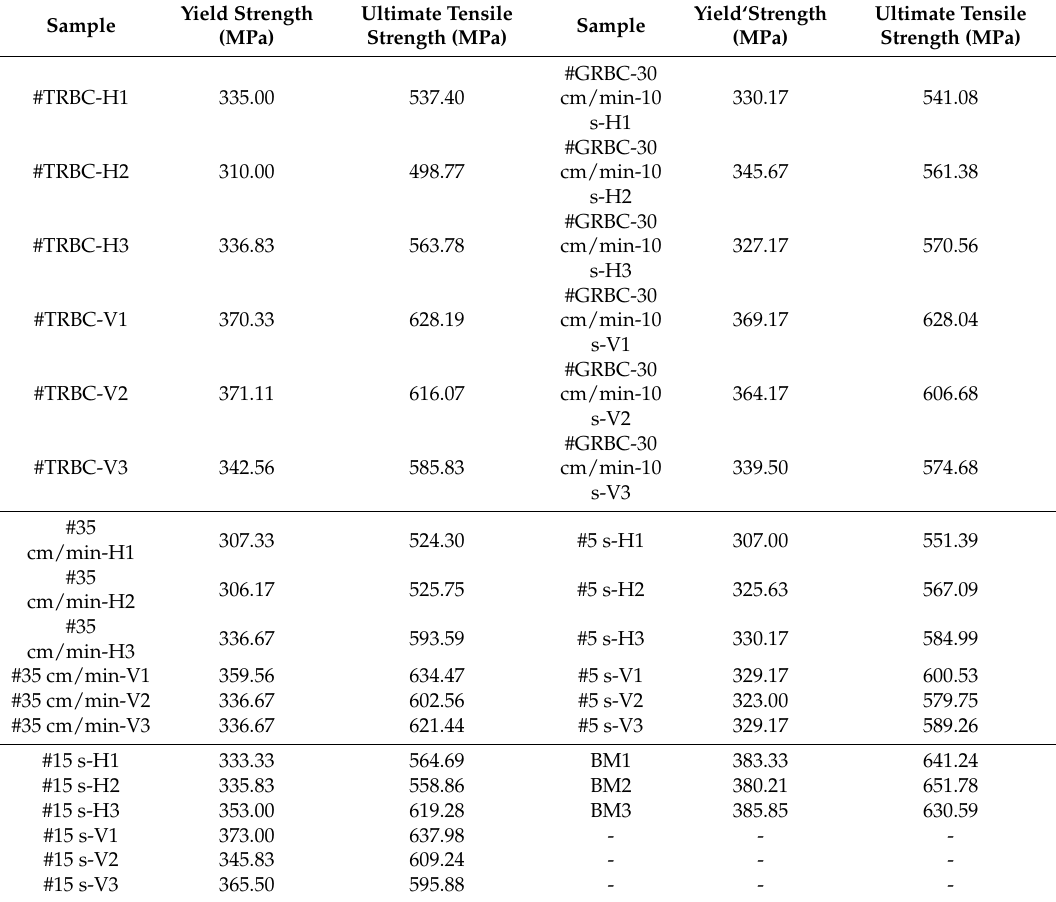
Table 4. Yield and ultimate strengths of tensile samples (BM represents substrate tensile sample, and TRBC and GRBC represent transient and gradual reduction of bottom current, respectively).